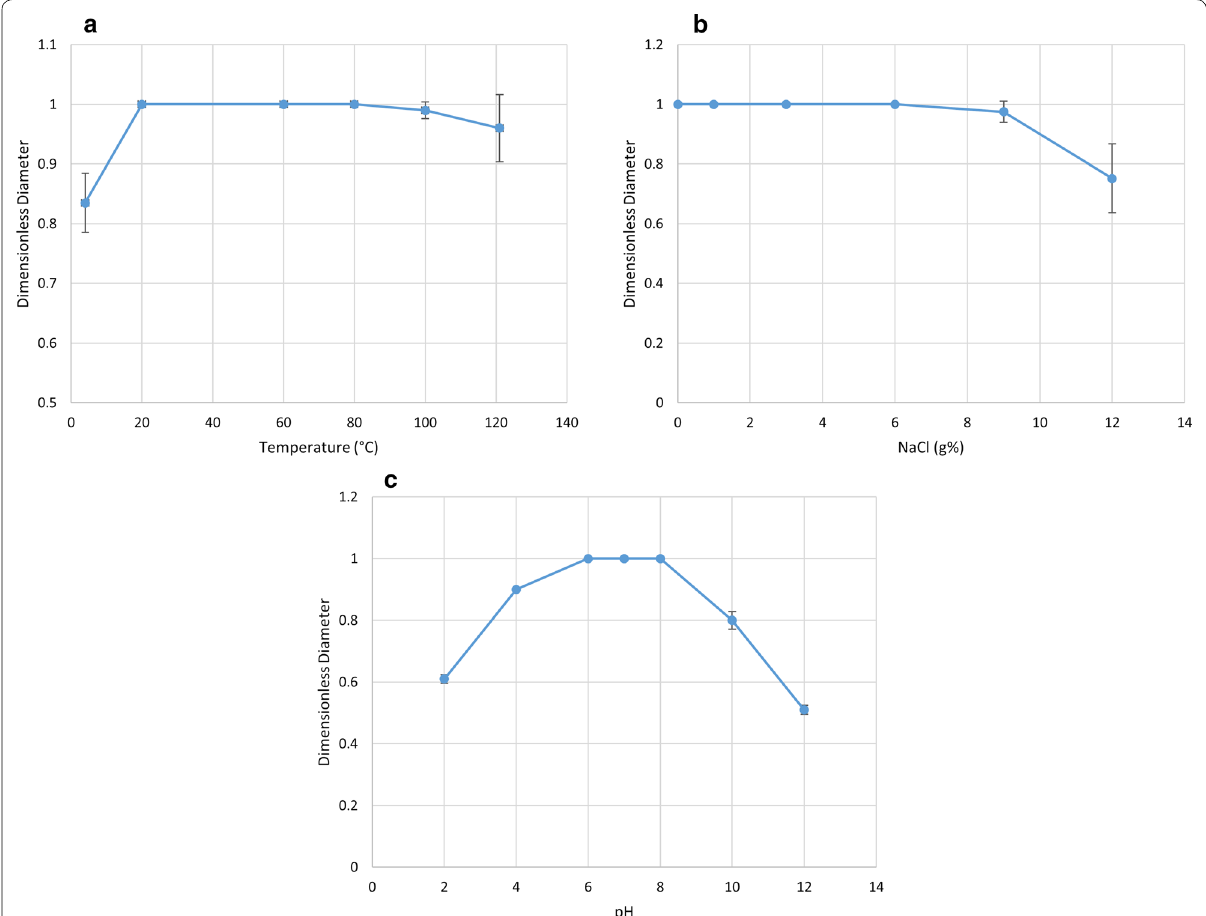
Fig. 5 Effect of a temperature, b salinity, c pH on the stability of the produced